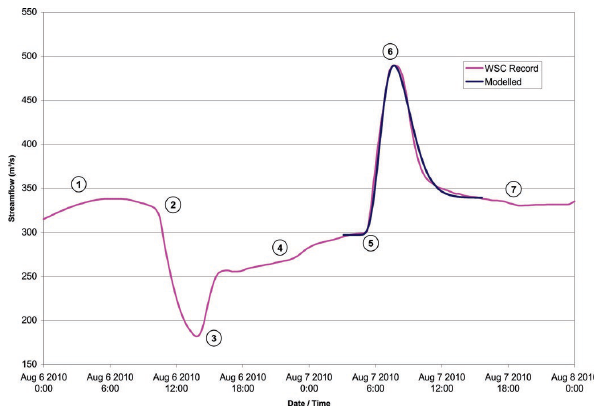
Fig. 16. WSC gauge 08MG005, Lillooet River near Pemberton. The gauge records the response of the Lillooet River at Pemberton to the Mount Meager landslide and subsequent damming events. Delay time to the station is approximately 6h and 45min. 1, sta- ble base flow (curve is diurnal fluxuation in stream flow); 2, initial drop in flow due to the complete blockage of Meager Creek, and partial blockage of Lillooet at 10:15; flow dropped to 182m 3 s − 1 ; 3, rapid recovery of flow beginning at 13:15 associated with the in- cision of Lillooet River through the landslide deposit; 4, continued gradual recovery of Lillooet River flow, minus the Meager Creek portion; 5, arrival of the Meager dam breach floodwave at 05:15; 6, arrival of the flood peak at 07:45; 7, re-establishment of stream flow conditions. The blue line represents the modelled dam breach and corroborates the observed stage discharge at